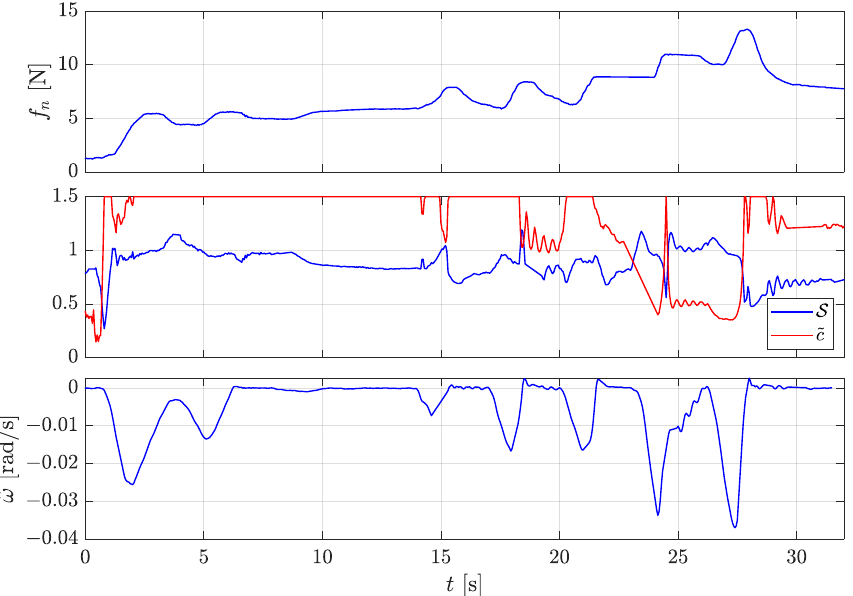
Figure 11. First experiment: lifting the big resin block. Top plot: grasping force. Middle plot: slippage indicator (blue) and estimated ˜ c (red). Bottom plot: estimated slippage velocity around the CoR (cid:98) ω .